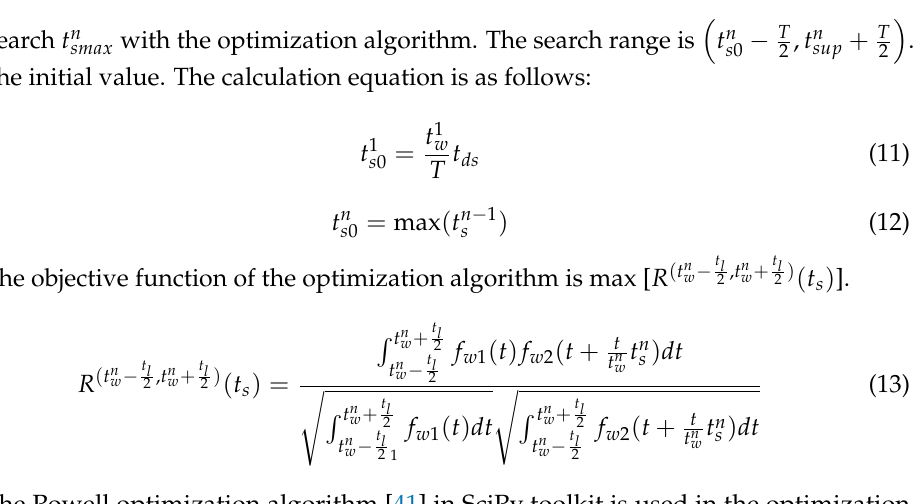
Figure 6. Flowchart of the improved method to calculate global wave velocity change.